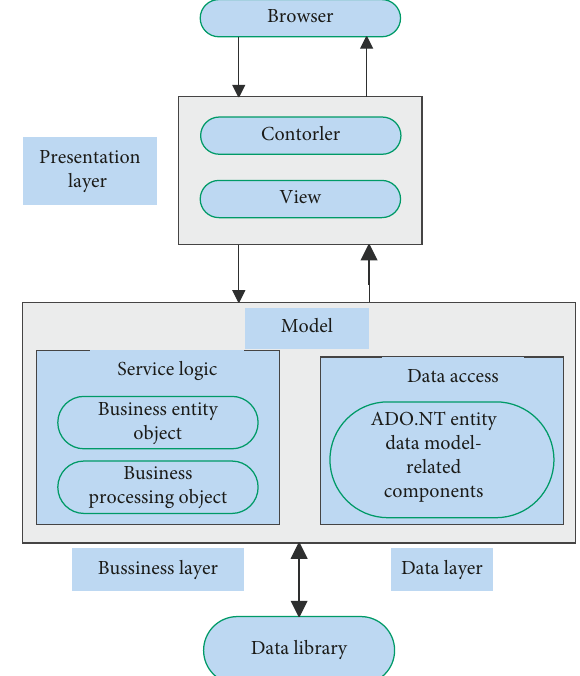
Figure 2: Schematic diagram of the basic structure of the MVC